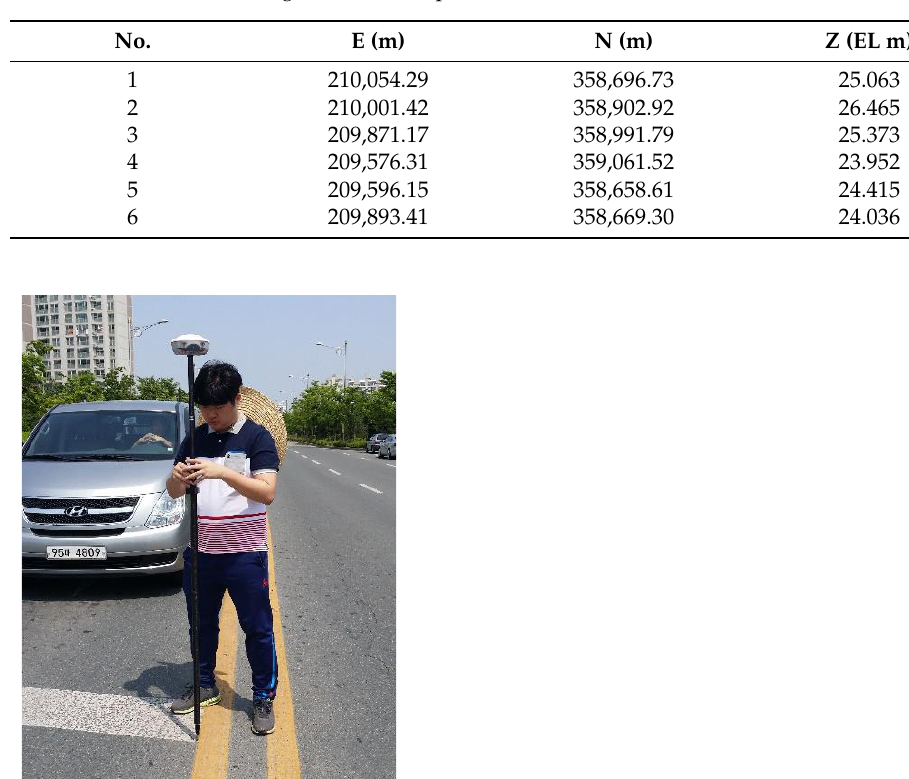
Table 3. Information of the ground control points.